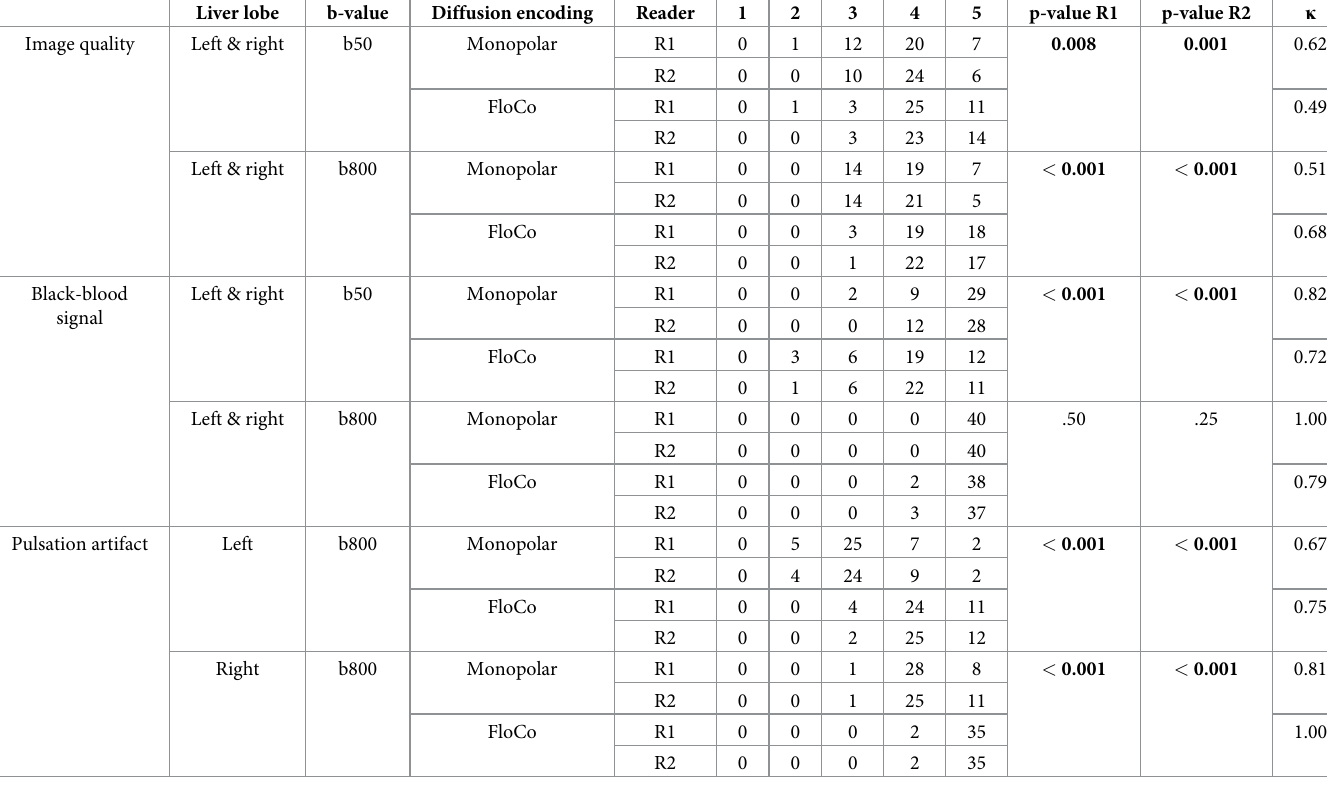
Table 4. Qualitative Likert score evaluation by reader 1 and reader 2 (same data as in Fig 7). Liver